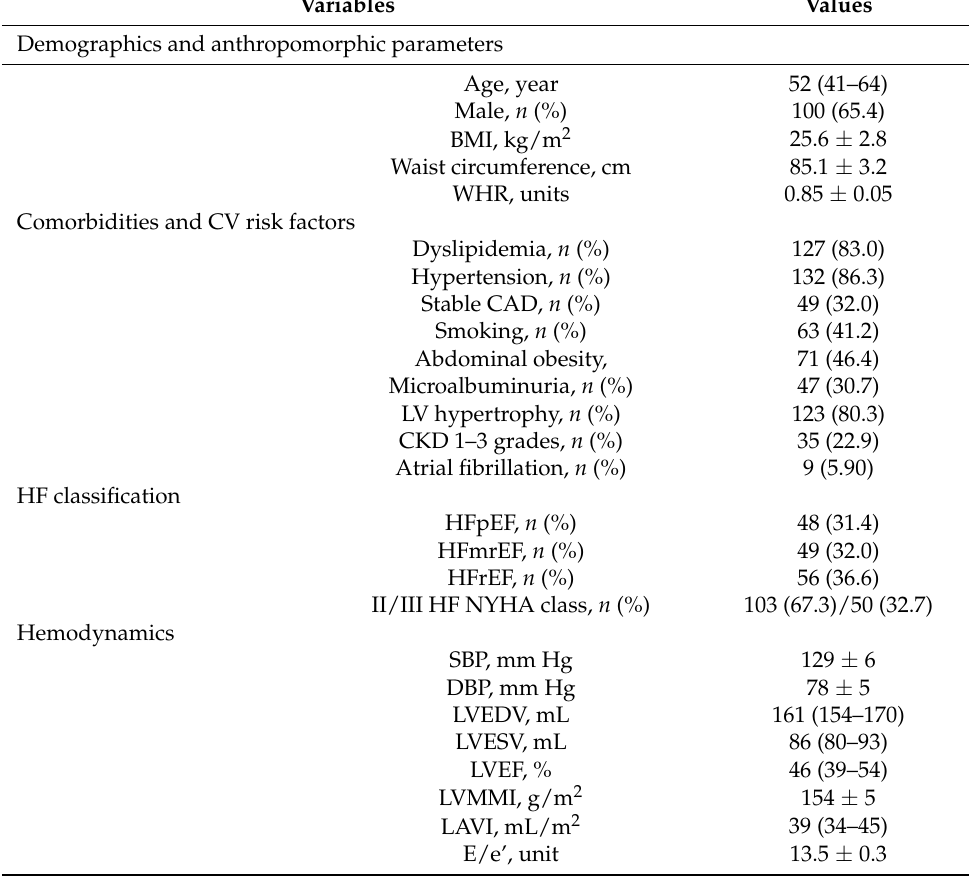
Table 1. Baseline characteristics of T2DM patients ( n = 153) included in the